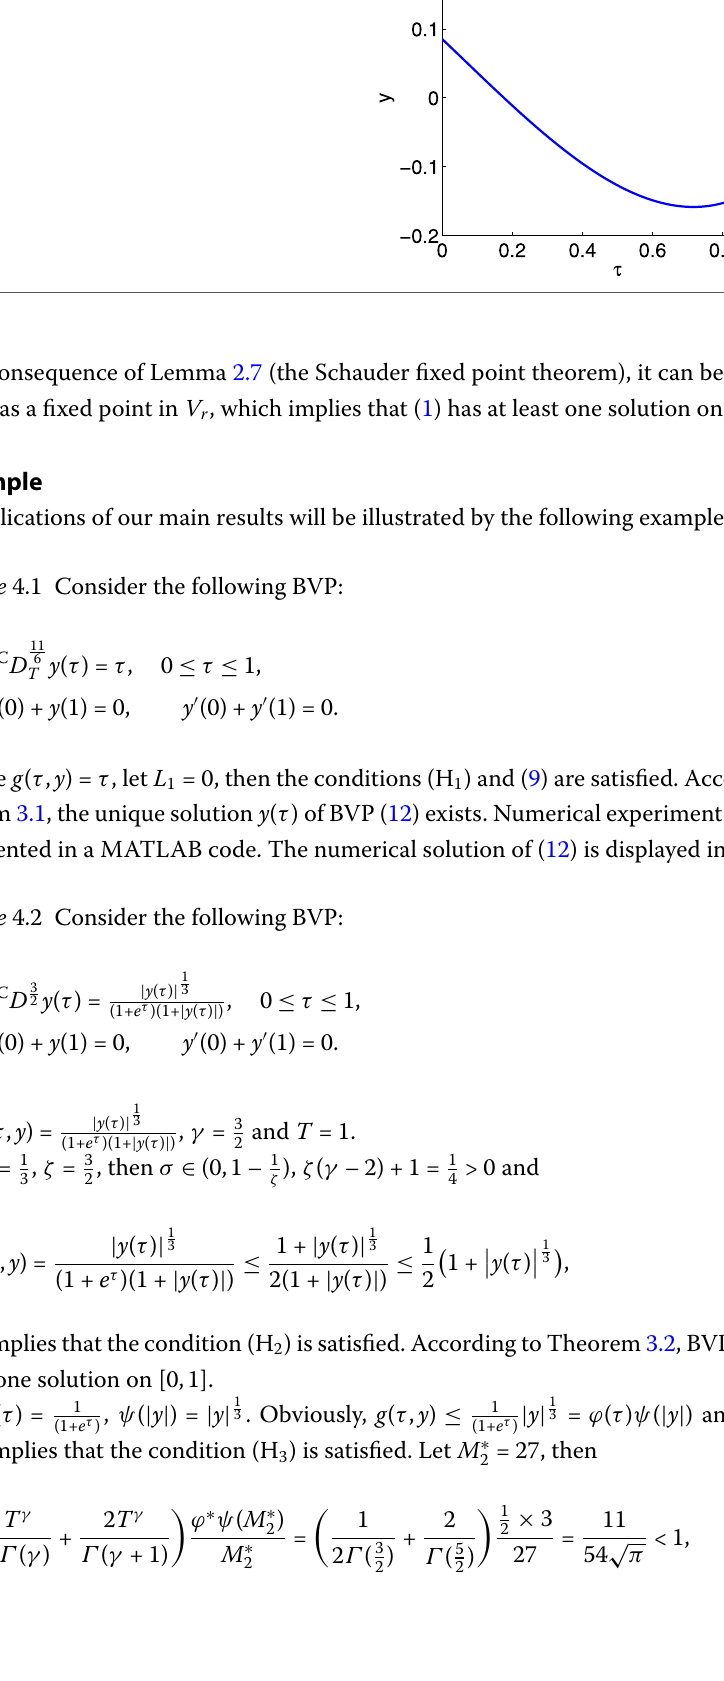
Figure 1 The numerical solution of